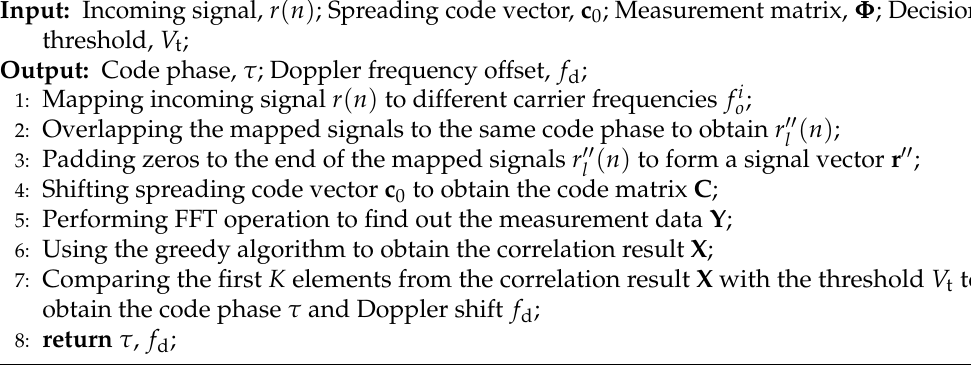
Algorithm 1 The proposed GNSS acquisition algorithm.